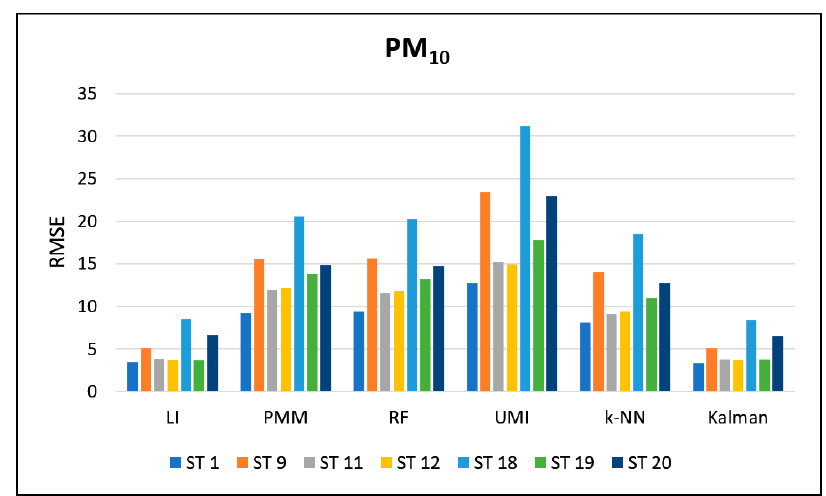
Figure 9. RMSE error for PM 10.